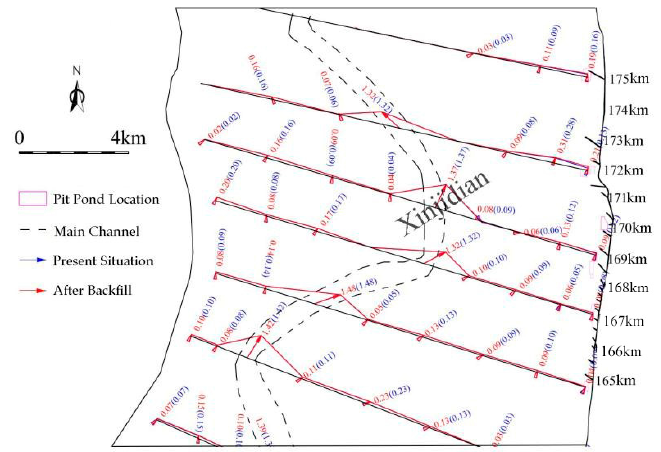
Figure 9. The velocity distribution under the floodplain condition (Q = 7000 m 3 /s).